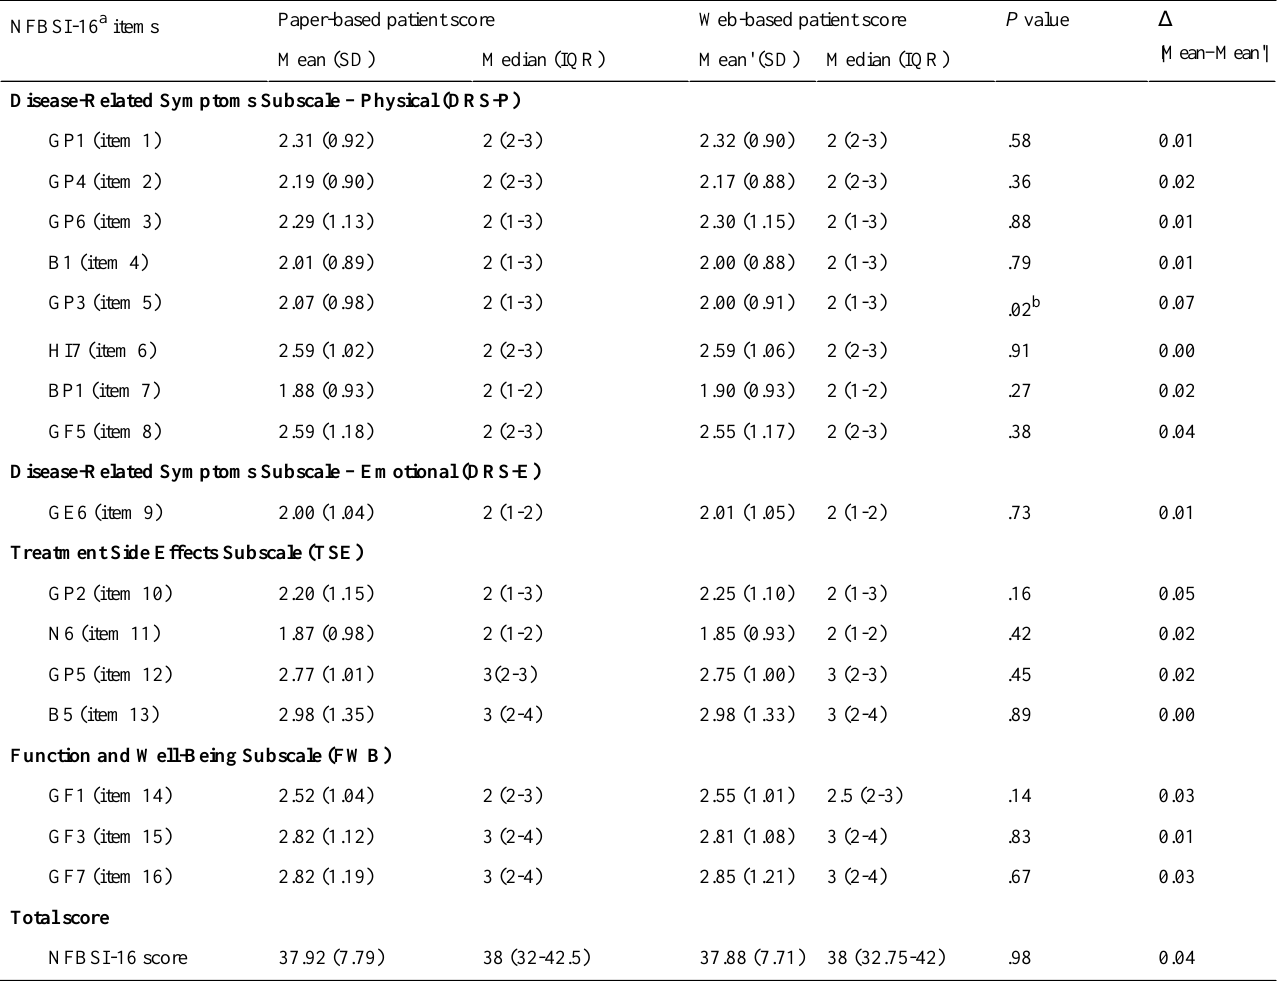
a NFBSI-16: National Comprehensive Cancer Network–Functional Assessment of Cancer Therapy–Breast Cancer Symptom Index. b Statistically significant